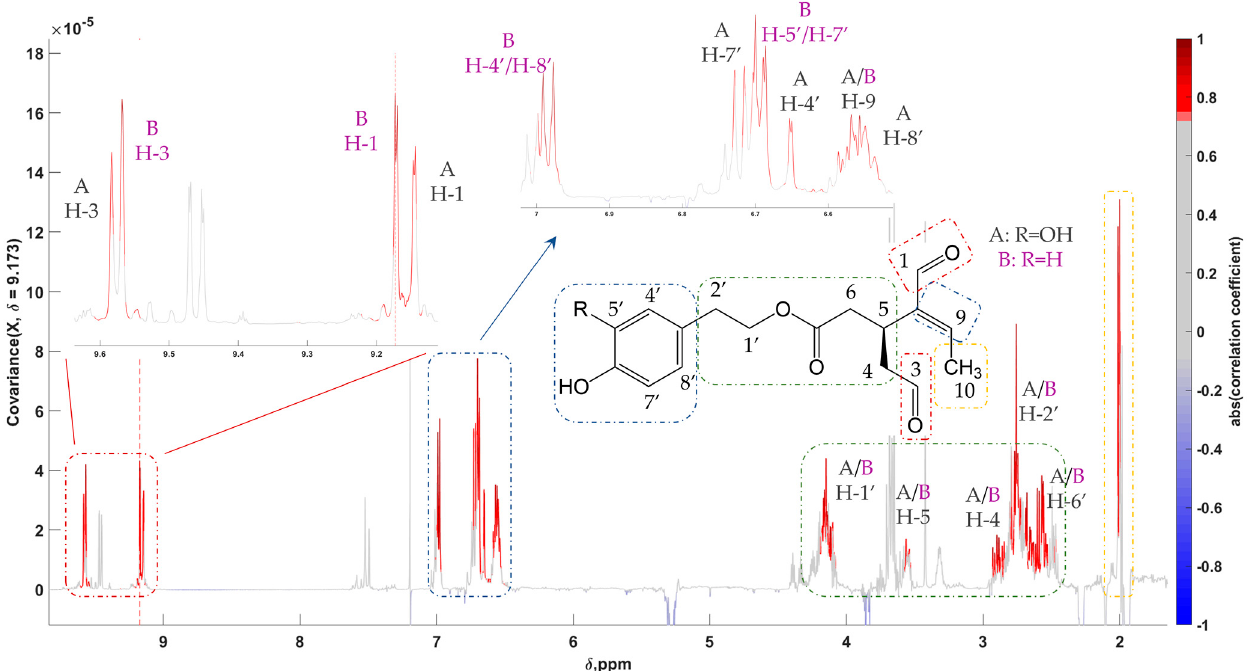
Figure 5. Statistical total correlation spectroscopy (STOCSY) 1D pseudo-NMR spectrum of oleacein ( A ) and oleocanthal ( B ). Correlation coefficients to the other signals in the median EVOO NMR spectrum are color-encoded: the “driver peak” was at 9.173 ppm. Zoom-in of the aldehydic and aromatic regions is also presented.